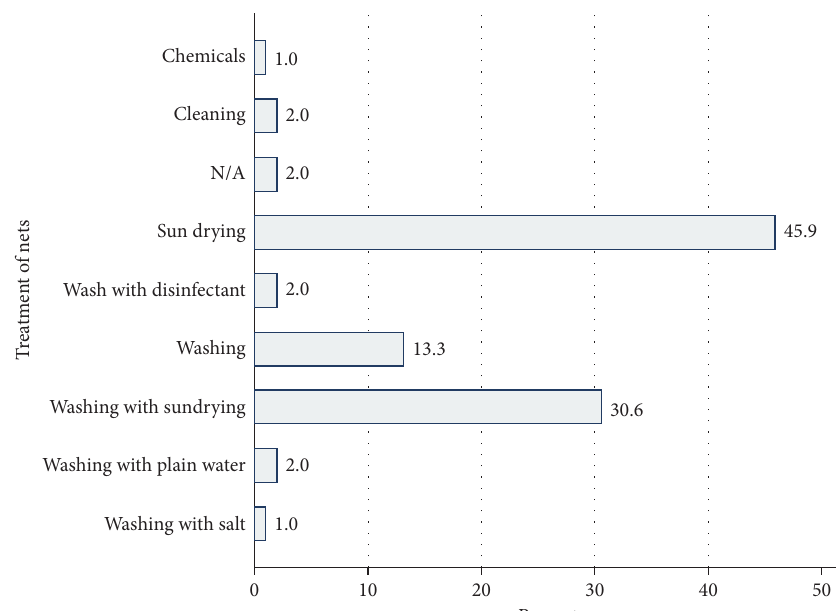
Figure 6: Different treatments of fishing nets postharvest in Nyeri County. Most of the farmers used washing and sun drying for treatment of nets, with very few using chemicals or salt.